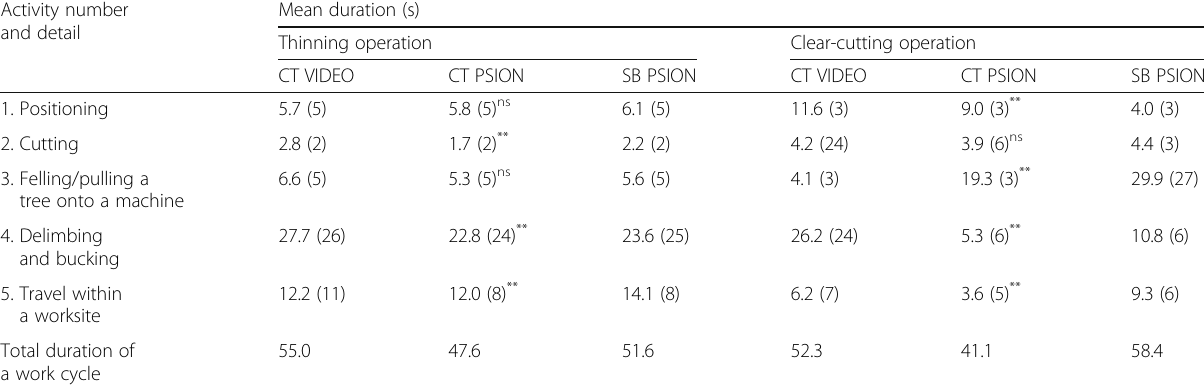
Table 3 Mean and median (in parentheses) duration of activities constituting a work cycle measured by either the VIDEO or the PSION